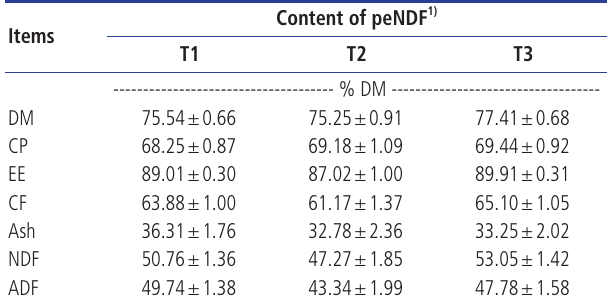
Table 5. Apparent nutrient digestibility in Korean native goats fed the TMR feeds with different peNDF contents